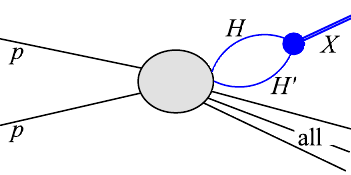
Figure 10. The mechanism for the inclusive production of the X as a HH (cid:17) bound state in proton–proton collisions. Here, all denotes all the produced particles other than the H and H (cid:17) in the collision. Figure from